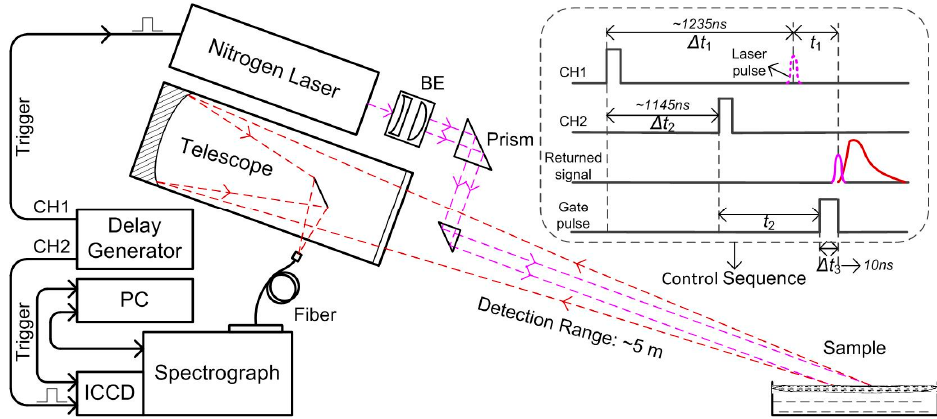
Figure 1. Schematic diagram of the time-resolved fluorescence experimental setup for laser remote sensing investigation of oil samples.